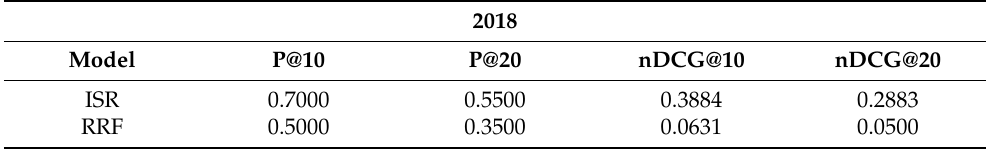
Table 6. The ranking performance results for applying two rank fusion methods, ISR and RRF, to combine the ranked lists of the nine LtR models for four years, 2018, 2019, 2020, and